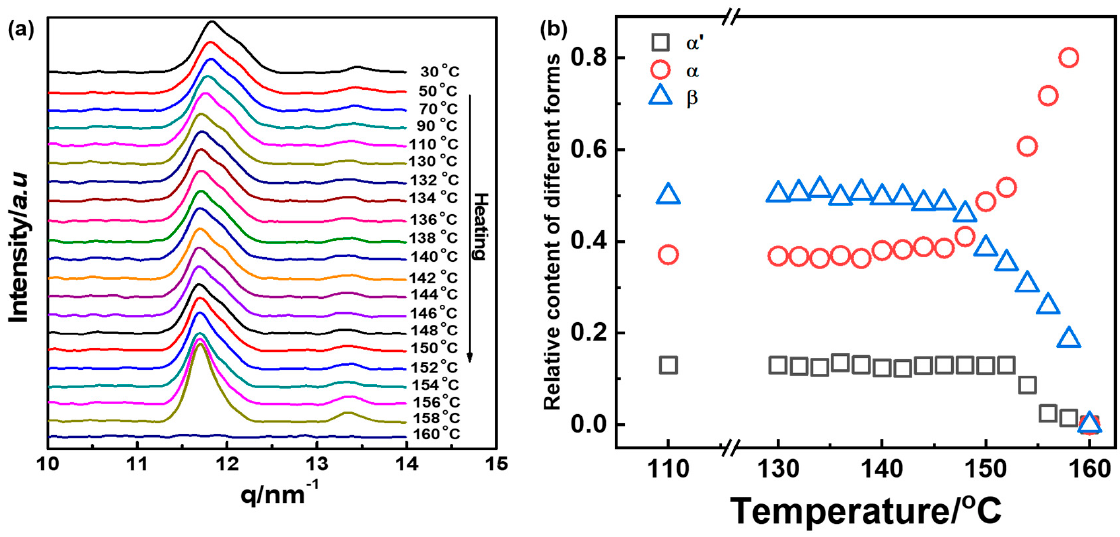
Figure 7. ( a ) Temperature-dependent WAXD curves of oriented PLLA film friction transferred at 100 °C. ( b ) change of relative content of α′ -, α -, and β -forms in the heating process. The heating rate is 5 °C/min.